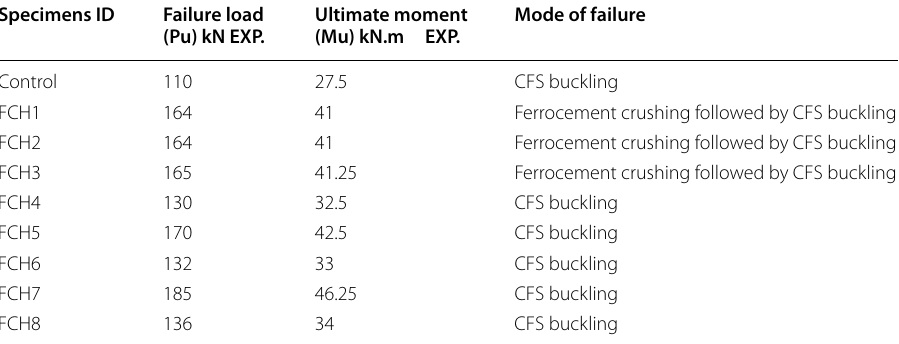
Table 2 Experimental results Specimens ID Failure load Ultimate moment (Pu) kN EXP. (Mu) kN.m